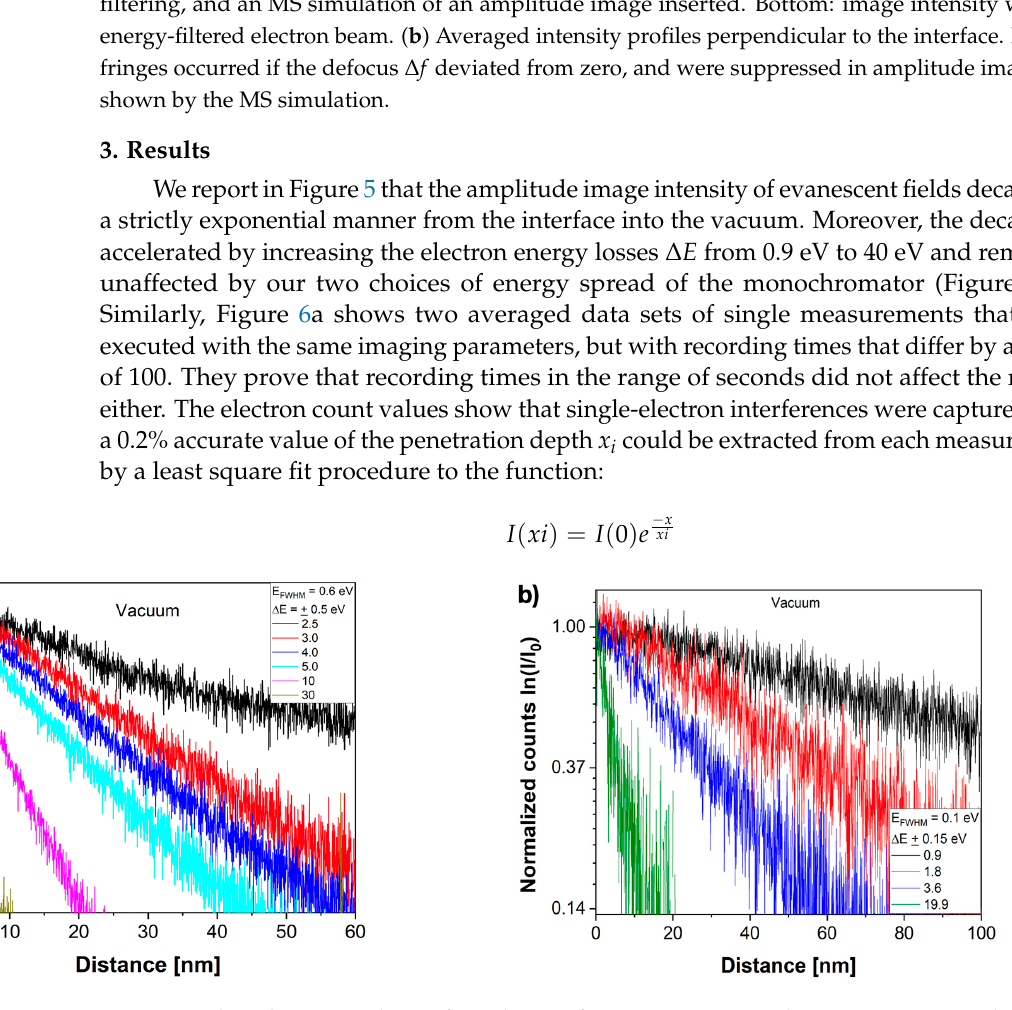
Figure 6. Energy-dependent penetration depth of the evanescent field. ( a ) The average electron count at the interface was about 1 electron. The intensity decay was strictly exponential I (0) e − x/xi with a characteristic distance x i that we determined with a least square fit procedure for various energy losses to obtain the data set of Figure 6b. The effect was independent of the recording time. ( b ) A reciprocal dependence of x i on energy loss was revealed. In this case, a fitting parameter, a, could be determined and compared to the propagation of wave packets at light speed by the elemental con- stant ℏ c = 197 eVnm > 106 eVnm = ℏ v = 1/a. It is understood that I (0) captures the intensity of the electron energy loss spectrum (EELS) at the chosen energy loss [1]. Most importantly, however, the exponential decay constants measured at various energy losses are plotted in Figure 6b, which indisputably prove that the energy loss dependence of the penetration depth followed the rule x i ≂ l e ~ 1/ E . We now make the ansatz that this exponential decay with relates to the formation of an evanescent field by the GHS being projected into the image, analogously to the light optical phenomenon [22]. It is consistent with a description of electron scattering by Schrö- dinger’s time-dependent equation. In this model, the fitting parameter 1/a in Figure 6b can be related to the elemental constant ℏ c for wave propagations in a vacuum at the speed of light when noting that the accelerated electrons travel at the speed v < c, and 1/a = ℏ v = 106 eVnm < 197 eVnm = ℏ c ((Equation (9)). This close agreement allows the interpretation of the penetration distance as a natural “delocalization distance” imposed by Heisenberg’s uncertainty principle, and allows estimating electron scattering cross-sections by the self-